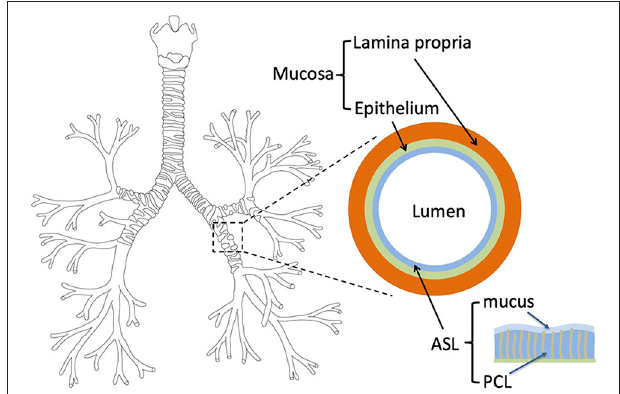
FIGURE 1 | Left : tree structure of the bronchial region of the human lungs. Right : layered representation of the bronchial mucosa, with the ASL, the epithelium and the lamina